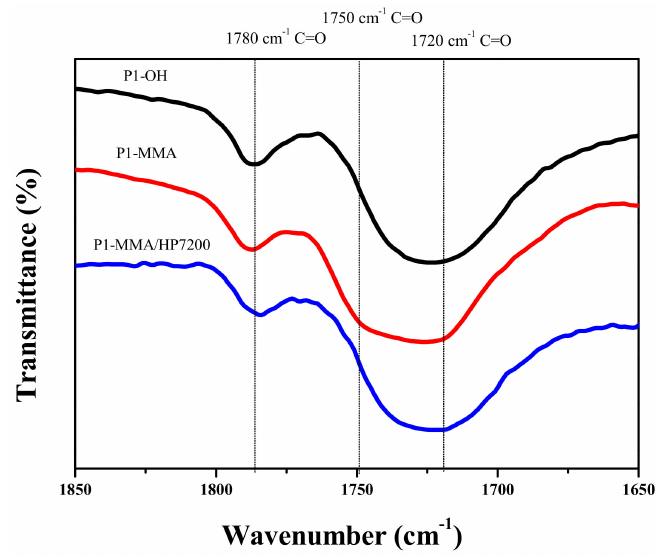
Figure 5. Enlarged IR spectra of P1–OH, P1–MMA, and P1–MMA/HP7200.